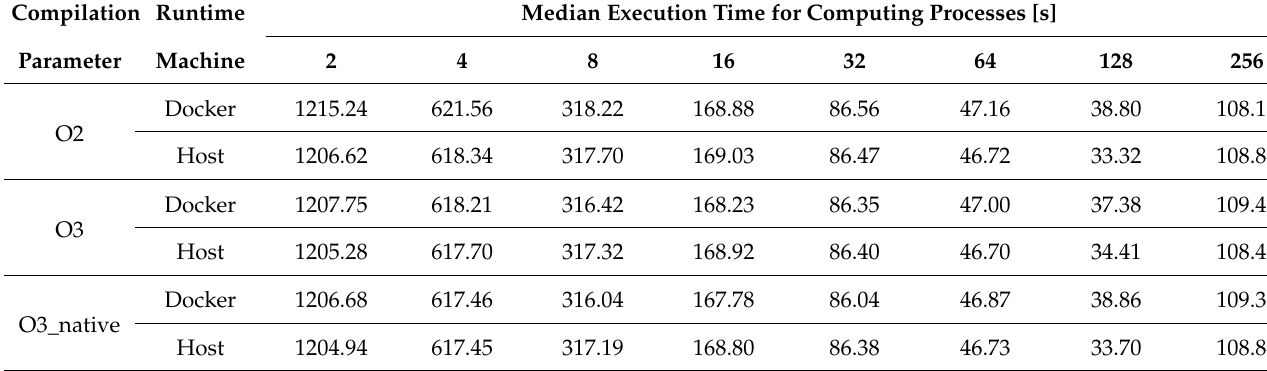
Table 3. Median execution times for